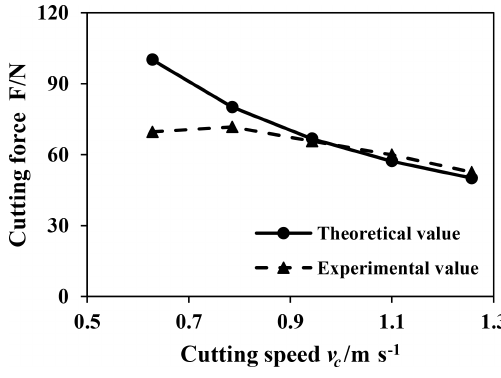
Figure 9. The change of cutting force with cutting speed.